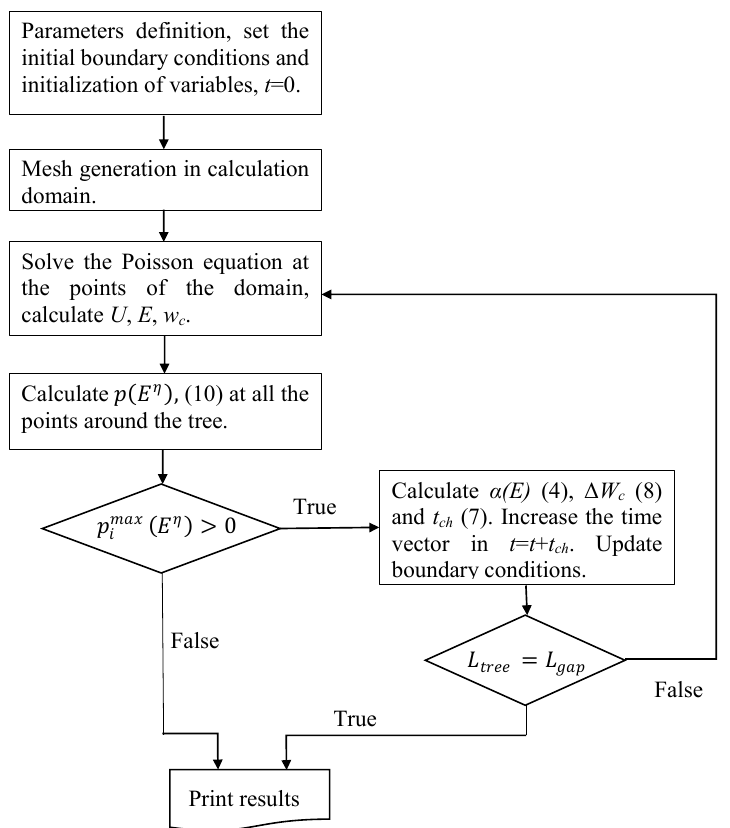
Figure 2. Model implementation flowchart. U (V) is the electric potential, E (V · m − 1 ) is the electric field strength magnitude, w c · (J · m − 3 ) is the potential energy density, L tree (m) is the tree length along the symmetry axis and L gap (m) is the pin–plane distance.